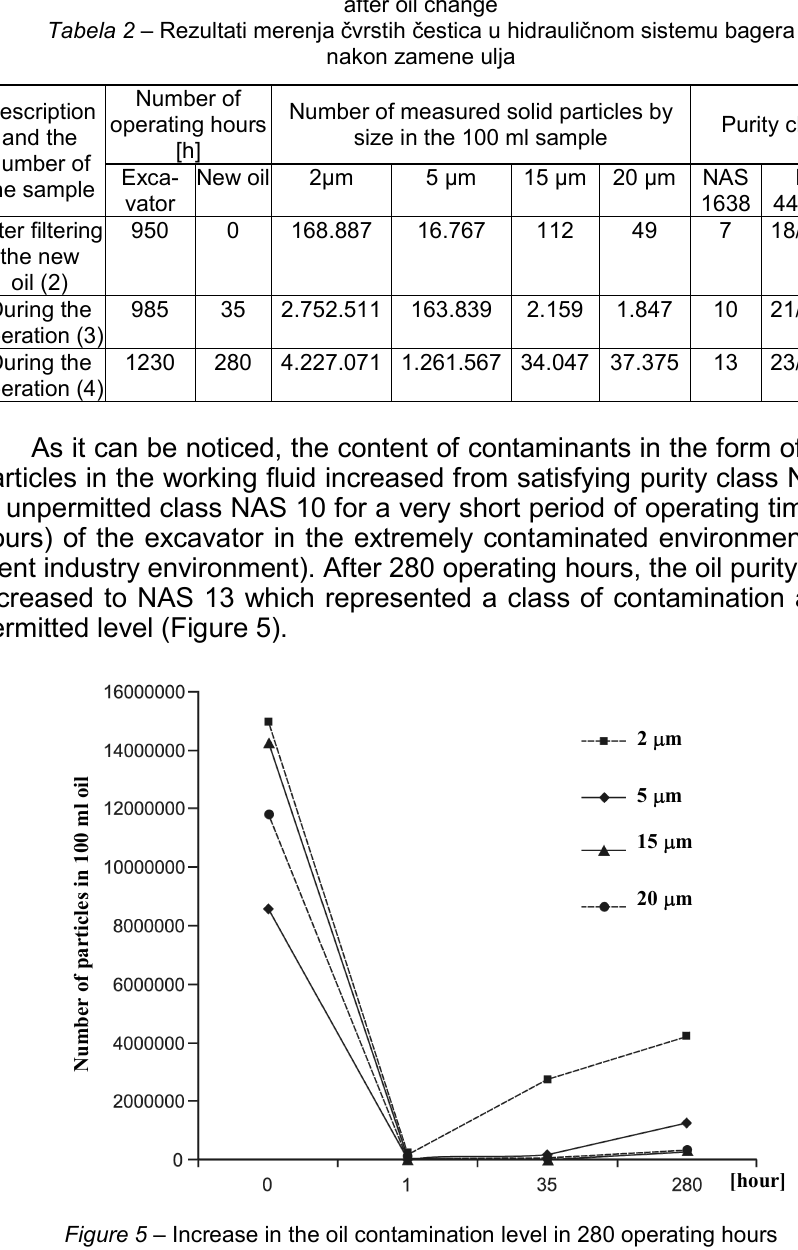
Table 2 – Results of measuring solid particles in the excavator working fluid mass after oil change